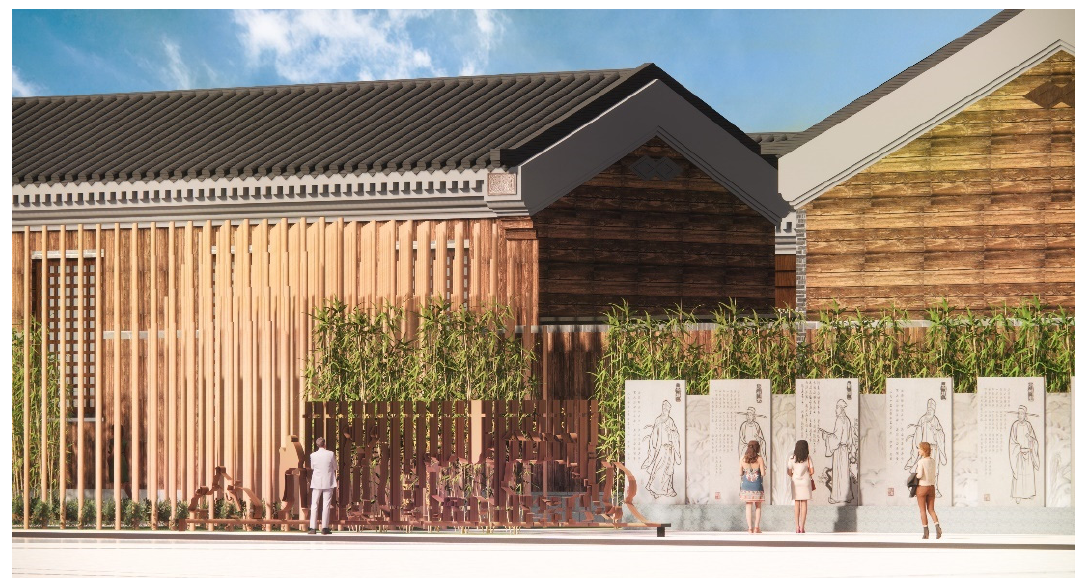
Figure 14. Ritual culture experience landscape space.